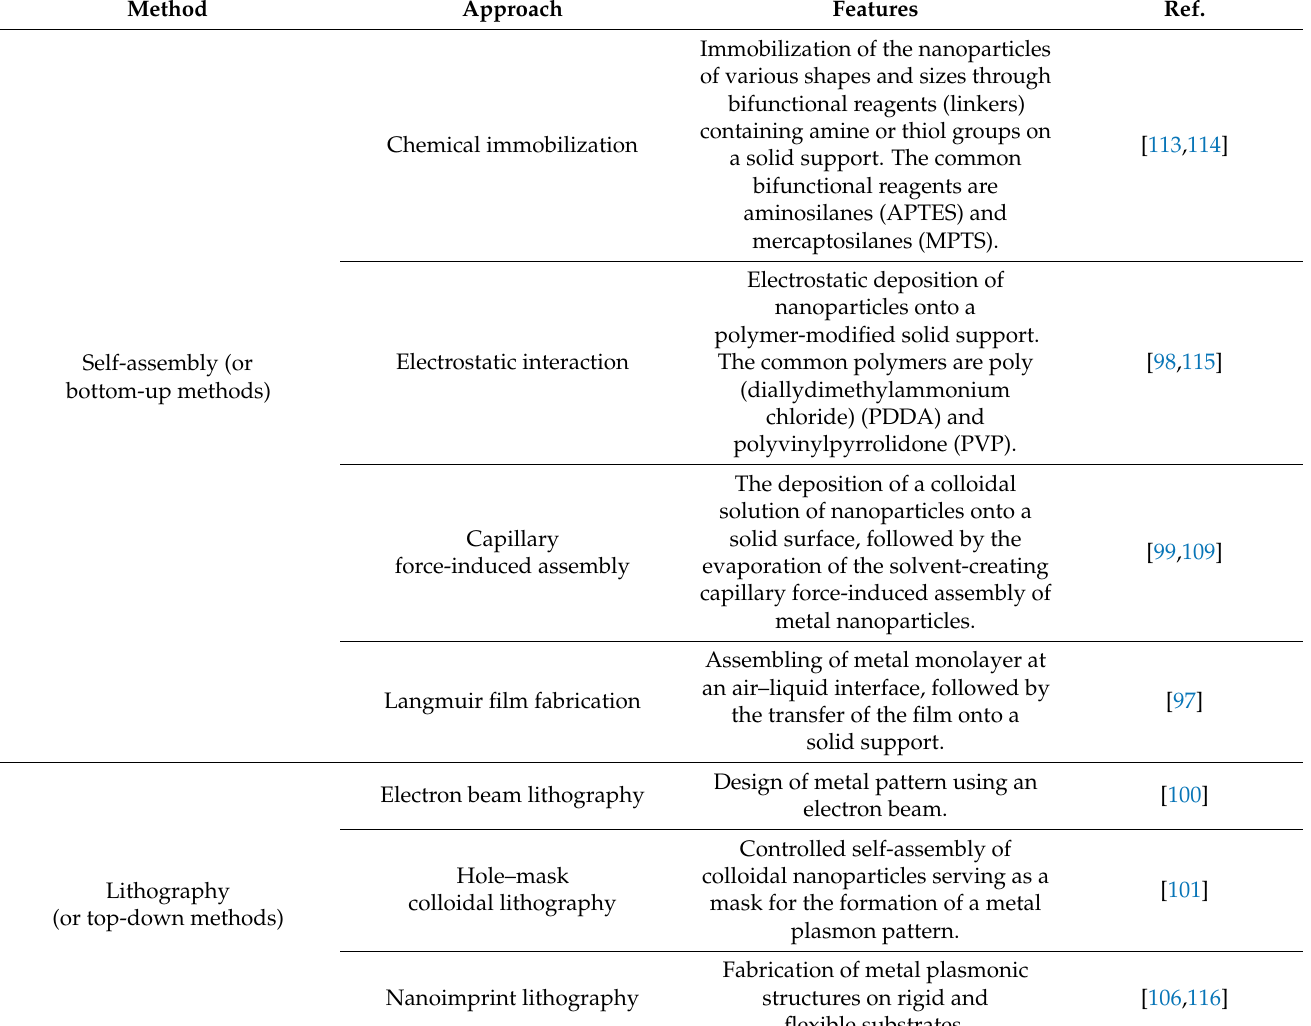
Table 1. Methods for fabricating SERS-active solid substrates, summarized according to the following reviews.